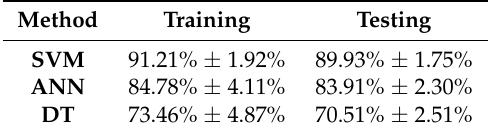
Table 2. Training and testing results for the three classifiers.